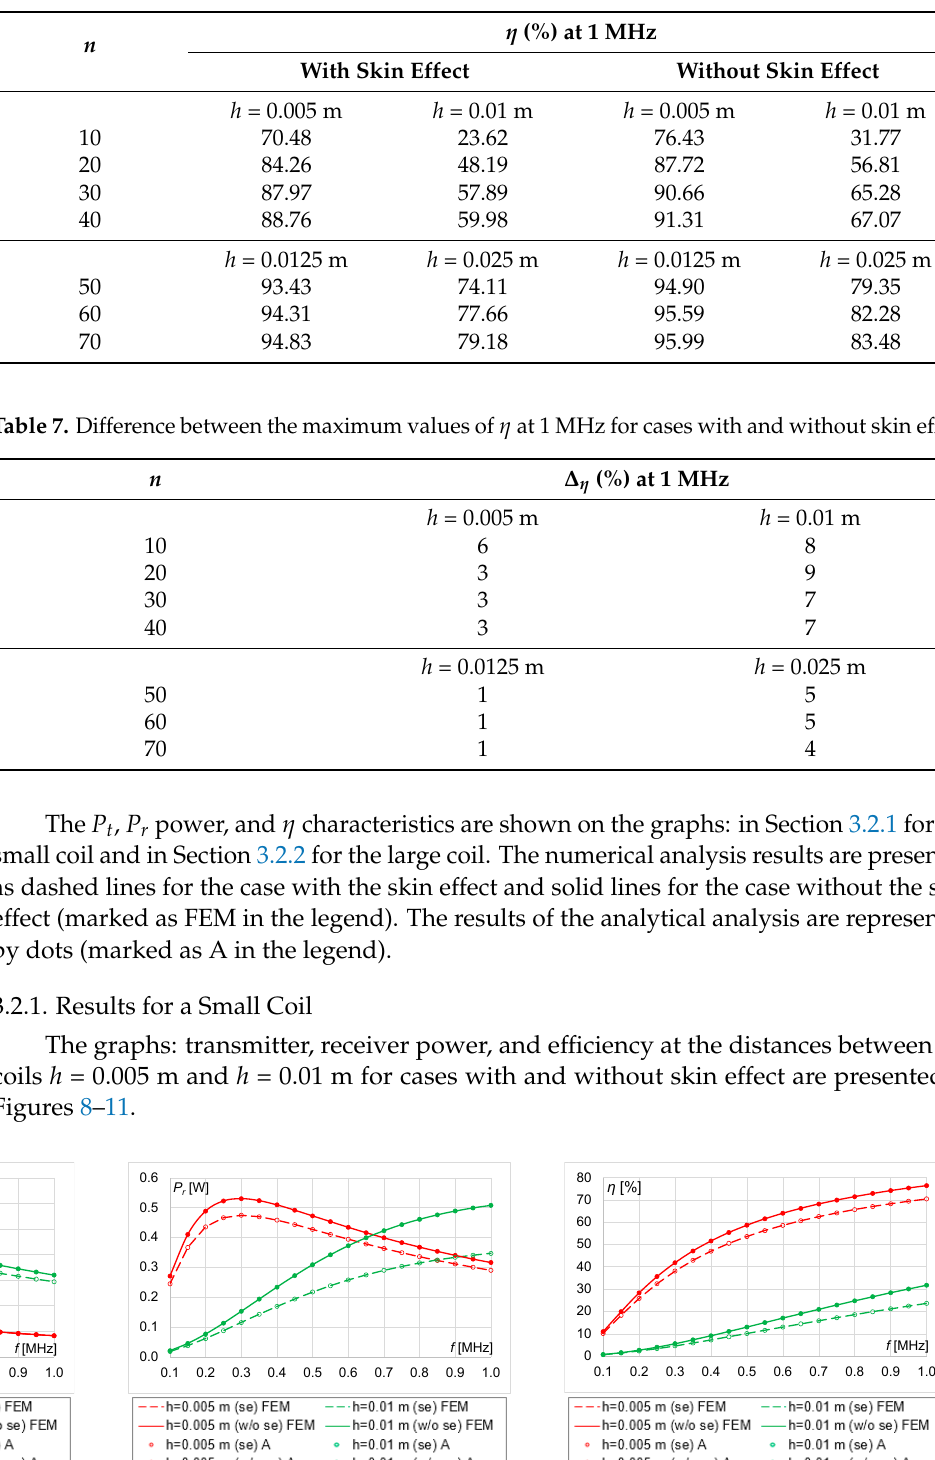
0.00.51.01.52.02.53.0